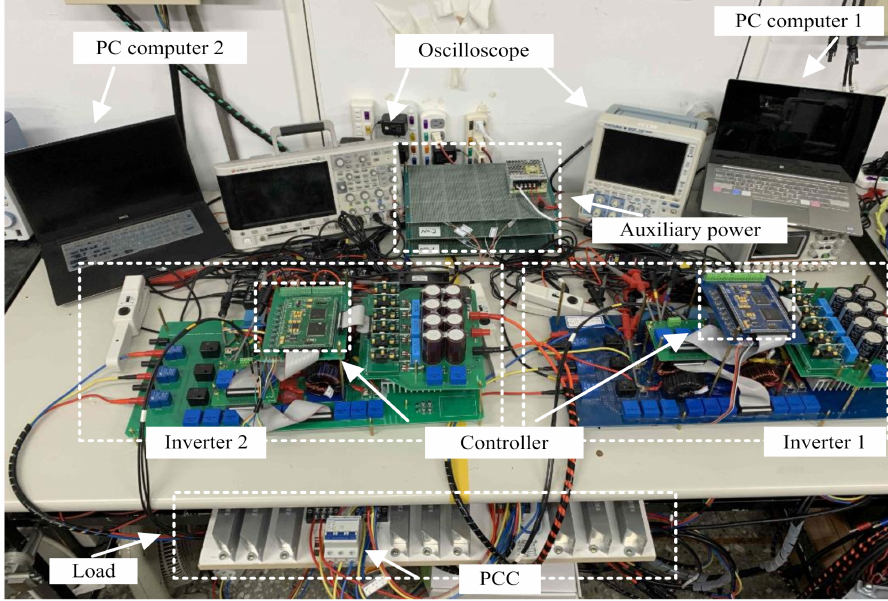
Figure 12. Experimental prototype.